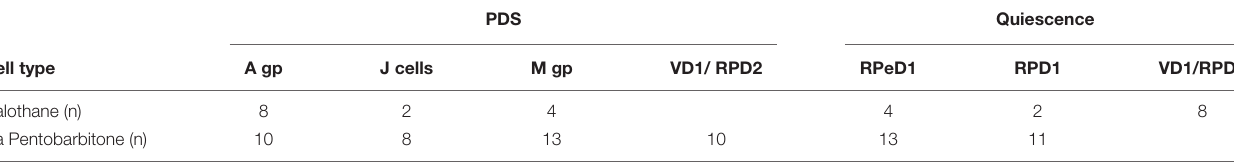
TABLE 2 | Differential actions of halothane and sodium pentobarbitone on specific cells and cell groups (see Figure 1 ) in the isolated brain of Lymnaea.